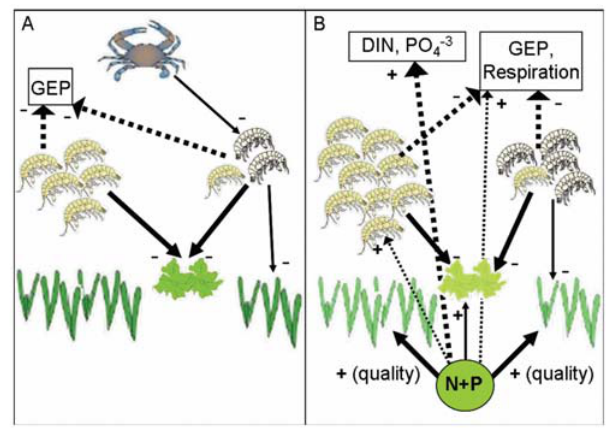
Figure 7. Synthesis of nutrient, crab, and grazer richness effects on major response variables. A and B represent treatments with crab predators and nutrient additions, respectively. Within each panel, the light-colored grazers on the left represent G. mucronatus monocultures while the grazers on the right are the multi-species treatments (i.e. minor grazers + G. mucronatus ). (A) Crab predators reduced minor grazer abundance but had no effect on G. mucronatus biomass. Despite the negative effect of crabs on minor grazers, there was no evidence of cascading trophic effects on primary producers or ecosystem process rates. (B) Nutrient additions increased the nutritional quality of primary producers which, likely, indirectly increased G. mucronatus biomass. Nutrient amendments increased DIN and PO 4 2 3 flux rates, respiration, GEP, and macroalgal biomass. In both A and B, gross ecosystem production (GEP) was reduced in all grazer treatments while Z. marina biomass was reduced in the mixed grazer species treatments only. Solid arrows are direct effects and broken arrows are indirect effects. Thicker lines represent effects with a v 2 . 0.50; thinner lines represent effects a v 2 of , 0.50. Low C:N primary producers are lighter in color than high C:N algae and Z. marina. The 2 and + symbols indicate the directionality of the effect. See Table 1 for statistical results. Symbols courtesy of the Integration and Application Network (ian.umces.edu/symbols/), University of Maryland Center for Environmental